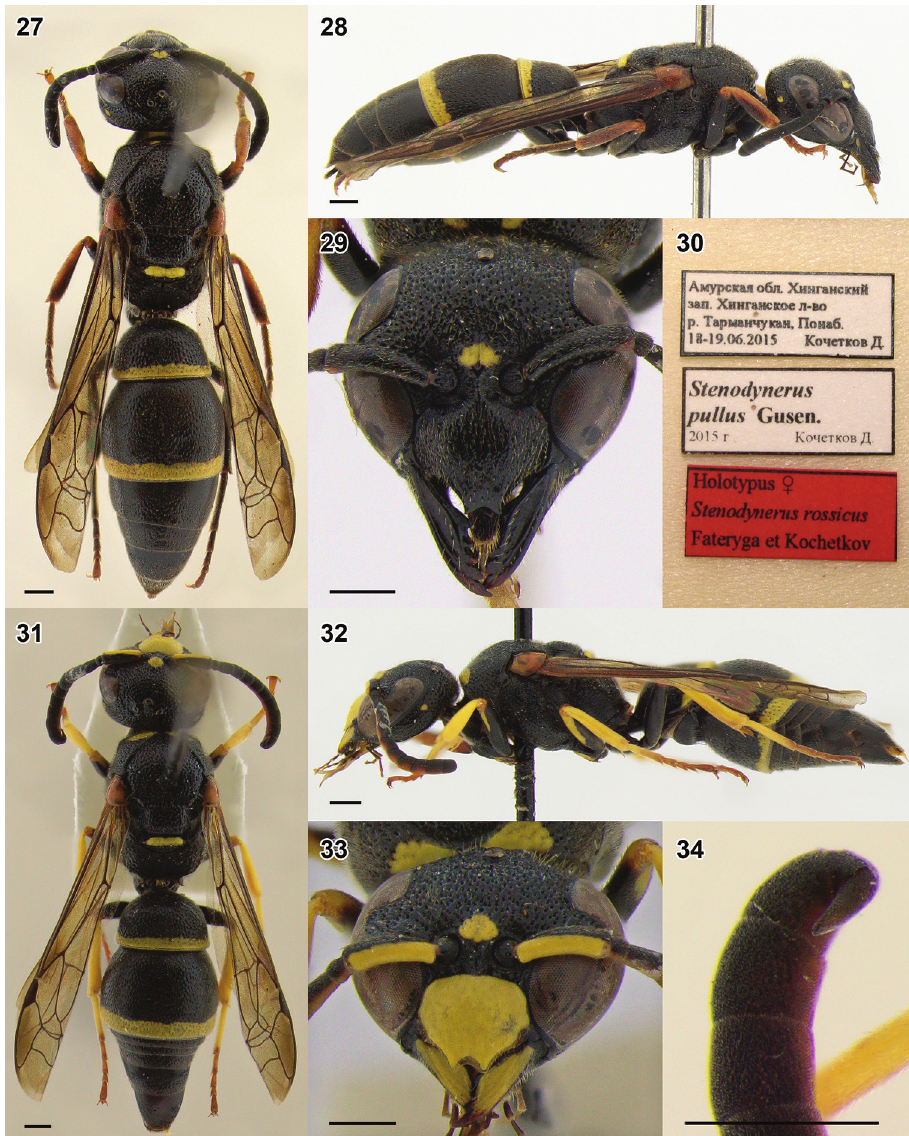
Figures 27–34. Stenodynerus rossicus Fateryga & Kochetkov, sp. nov., Russia (Amurskaya Prov.), holotype, female ( 27–30 ) and paratype, male ( 31–34 ) 27, 31 dorsal habitus 28, 32 lateral habitus 29, 33 head in frontal view 30 labels 34 apex of antenna. Scale bars 0.5 mm. related species is S. picticrus (Figs 40–44), whose habitus, female color pattern, and male clypeus are similar to those of S. rossicus sp. nov. but which has a flattened scutellum and distinctly longer T1 in dorsal view [both in S. rossicus sp. nov. and S. punctifrons , the scutel- lum is evidently convex and T1 is remarkably shorter than long in dorsal view]. The